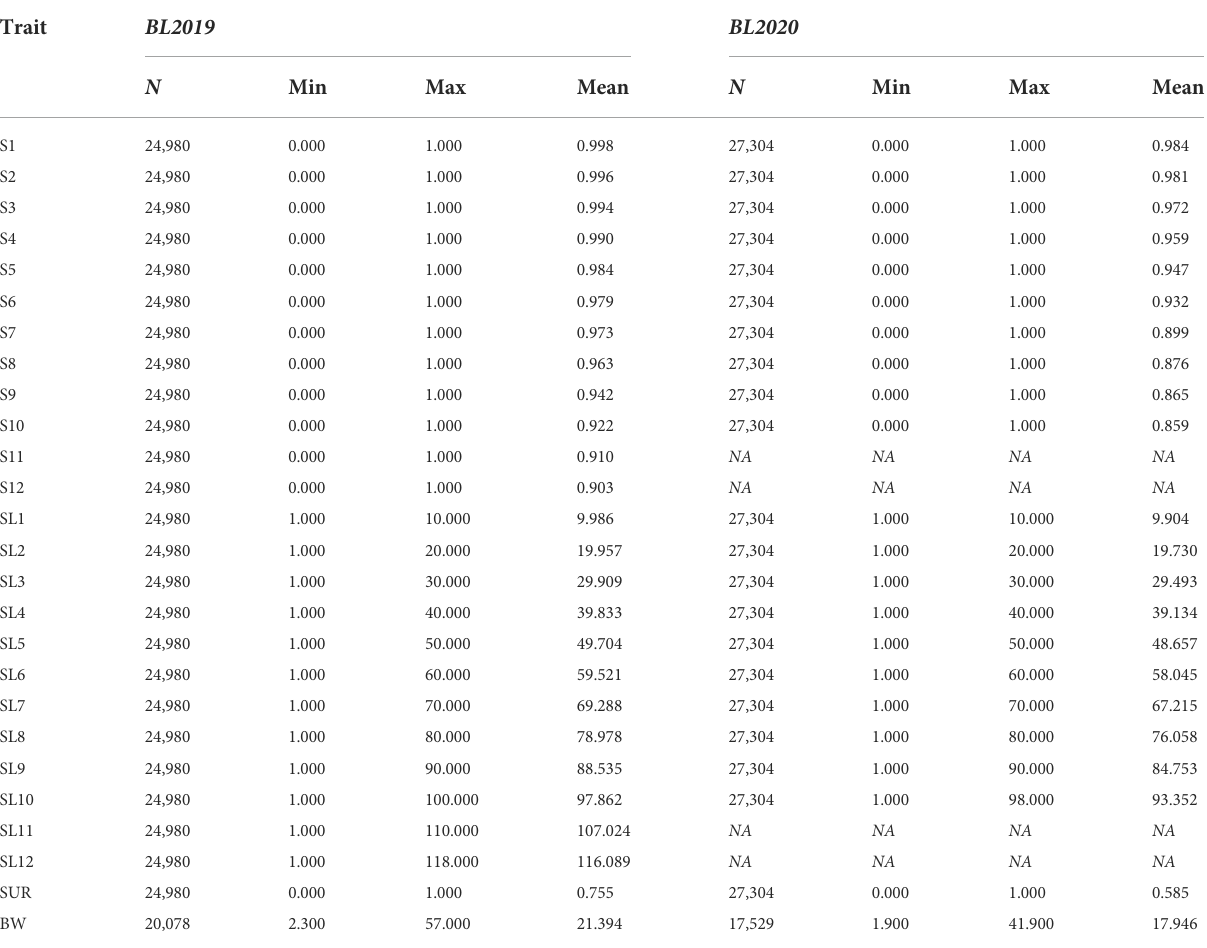
TABLE 2 Descriptive statistics of phenotype traits for the breeding lines of BL2019 and BL 2020. Trait